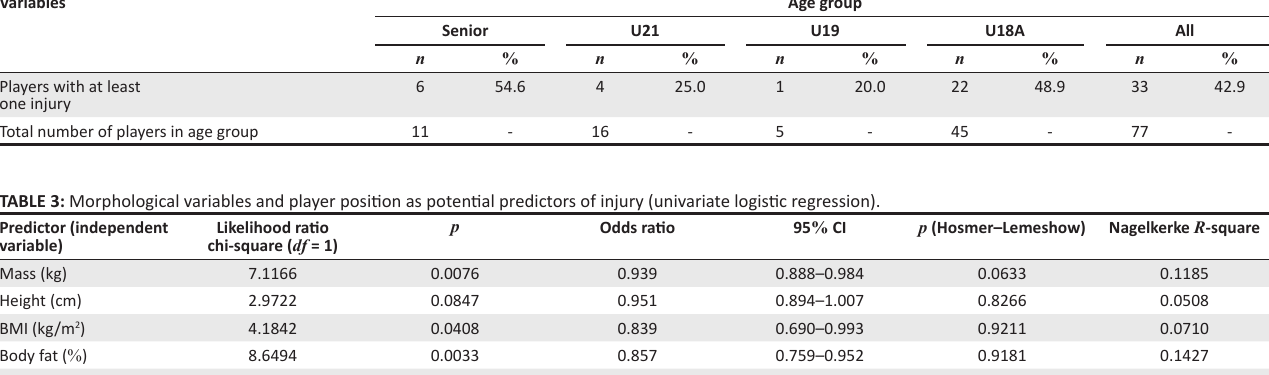
TABLE 2: Players with fitness data and at least one injury in the 2017–2018 seasons, by age group. Variables